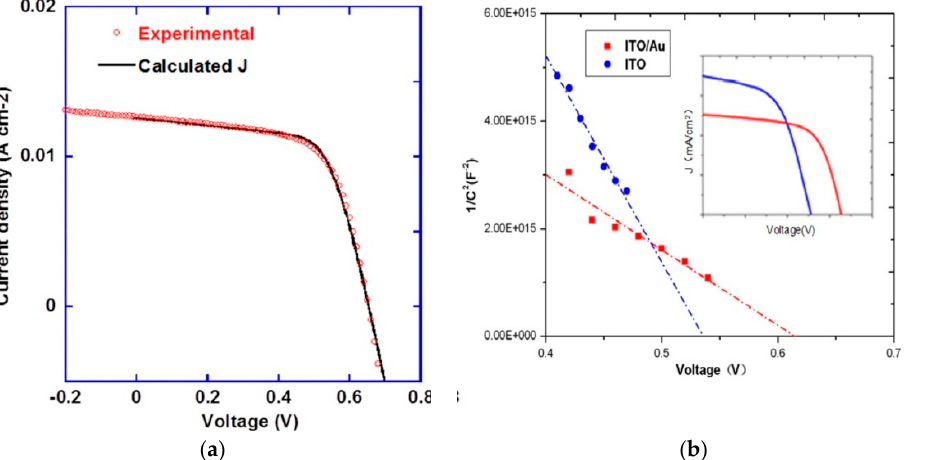
Figure 3. ( a ) J ‐ V curve of the CdTe solar cells with a 1 nm Au interlayer (solid lines represent the simulation results, while open circles represent the experiment results); and ( b ) Mott ‐ Schottky curves in dark conditions measured at a constant frequency of 1000 Hz for the CdTe NC solar cell device wihtout an Au interlayer. Reproduced with permission from [37]. Copyright 2010, IOP Publishing.